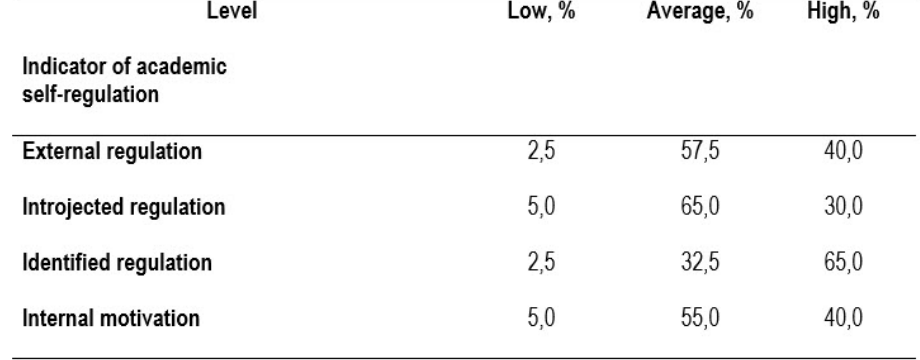
Indicators of motives of student self-regulated learning activity (according to the Questionnaire “Academic Self-Regulation” by R. Ryan & D.